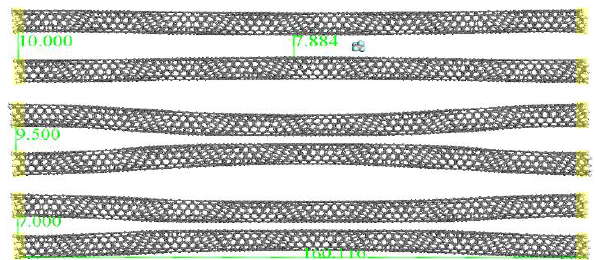
Figure 19. Molecular mechanics of tube–tube collapse when held apart at only the very end of each tube. The +2Ru2 complex creates a ~1 nm gap between two SWCNTs (top set). The +2Cu2FcOH separates the tubes by less than 0.7 nm (bottom set).